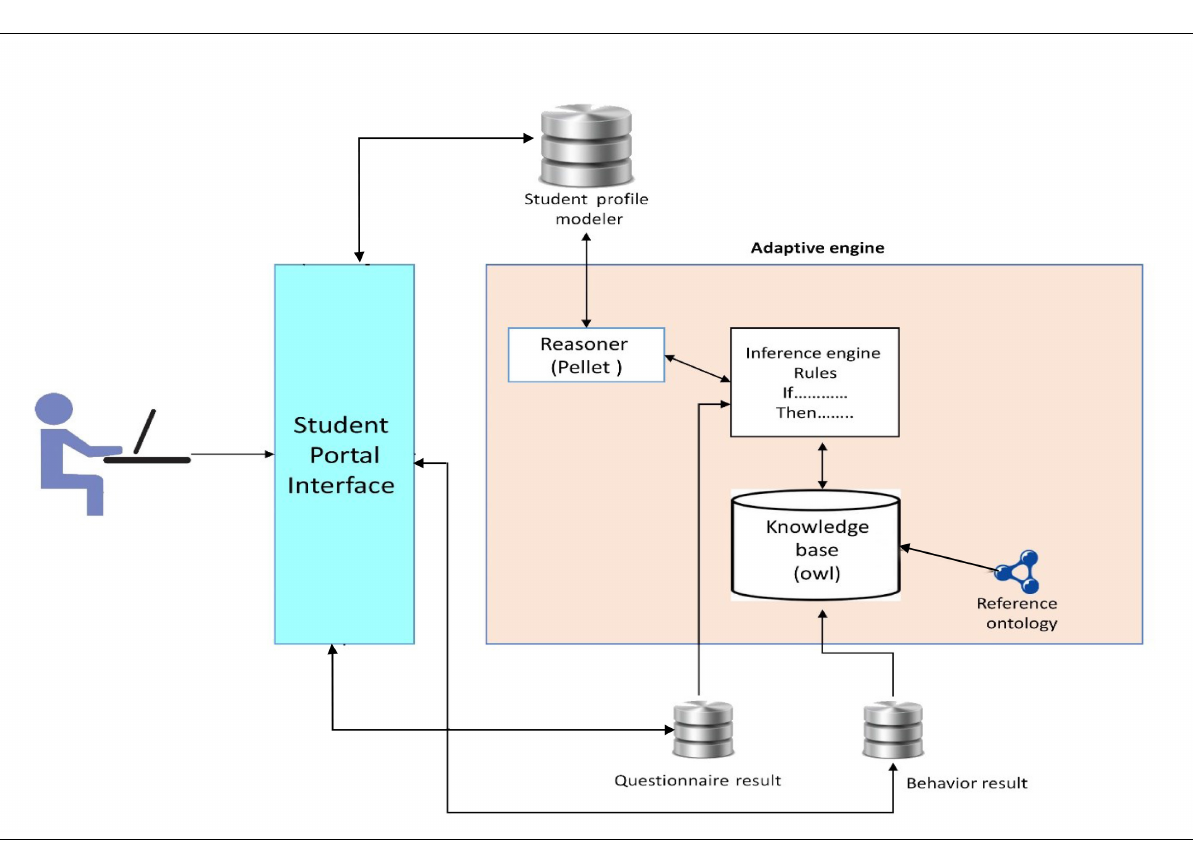
Figure 6. Adaptive engine components